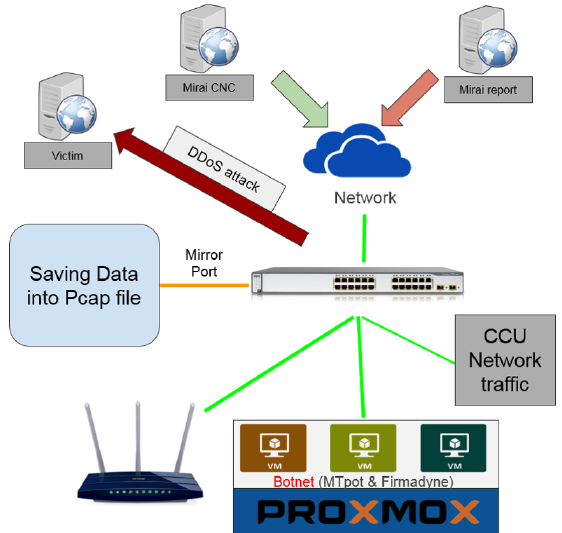
Figure 1. The testbed of our Mirai-based DDoS dataset in the campus of National Chung Cheng University